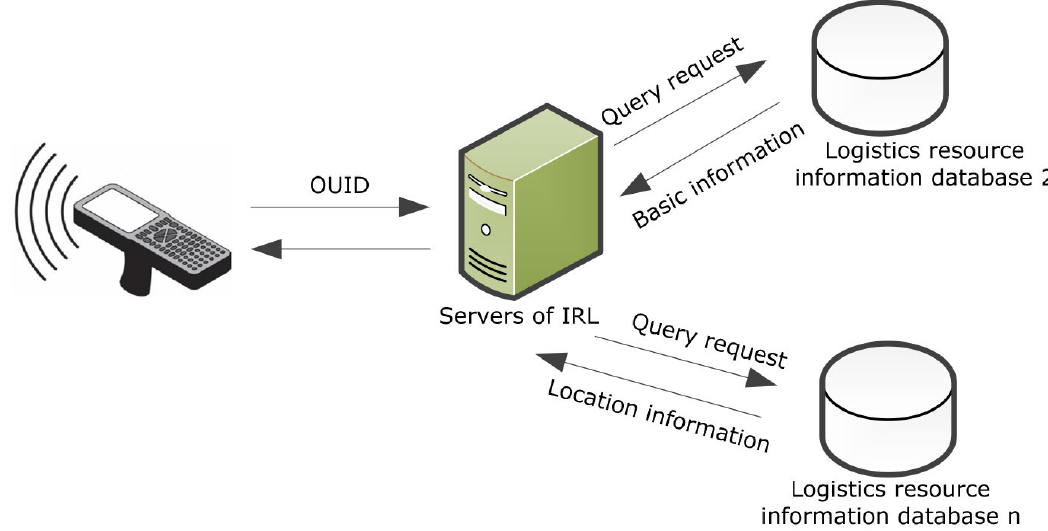
Figure 8. Process of RFID Information